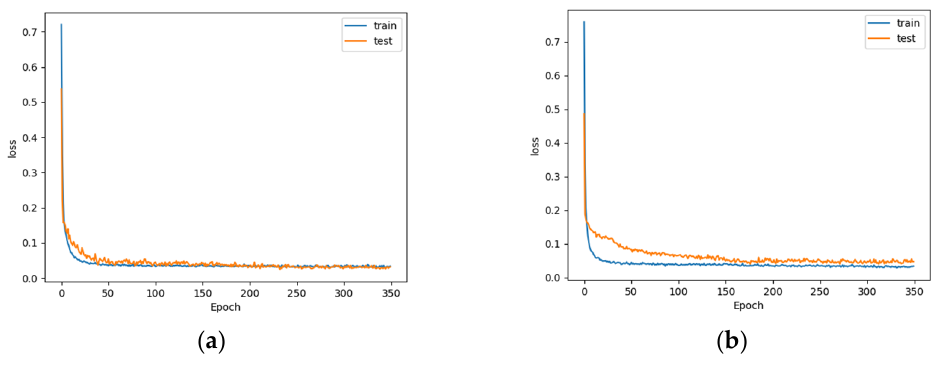
Figure 5. Loss changes ( a ) of call option; ( b ) of put option .